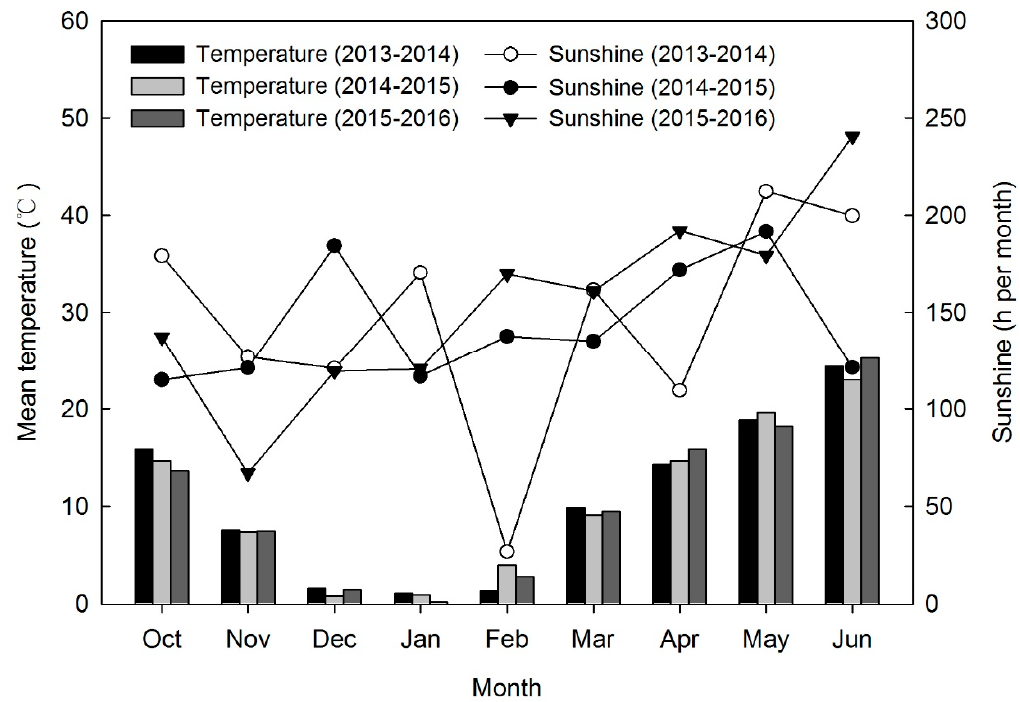
Figure 1. Monthly average air temperature and sunshine hours during the three growing seasons